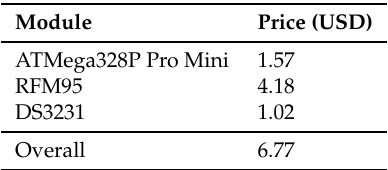
Table 4. Price of the overall beacon